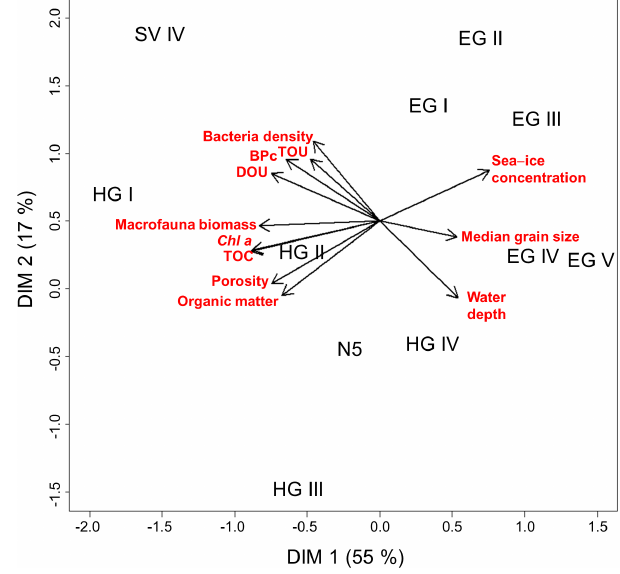
Figure 5. Visualization of PCA results on standardized ex situ mean values of abiotic parameters (water depth, sea-ice concen- tration, median grain size, porosity), biogenic compound parame- ters (chlorophyll a , Chl a ; total organic carbon, TOC; organic mat- ter), benthic community parameters (bacterial density, macrofauna biomass), bioturbation potential (BPc), and diffusive and total oxy- gen uptake (DOU, TOU). All other parameters were excluded from the PCA as they correlated strongly with one of the mentioned parameters (correlation >0.74, Pearson correlation, Table S2). For comparability, Station SV I was excluded from the PCA. Therefore, the figure reflects relations of different parameters in the Fram Strait in water depths of